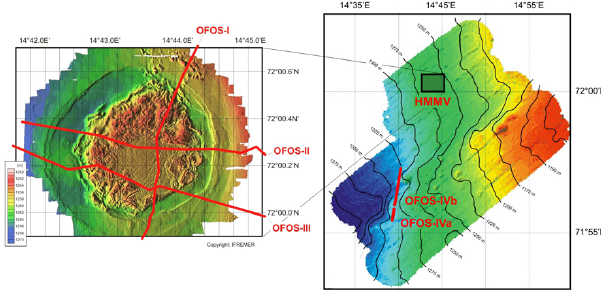
Fig. 2. Positions of the OFOS transects I, II and III taken across the H˚akon Mosby mud volcano caldera area and the reference transect IV taken outside the volcano